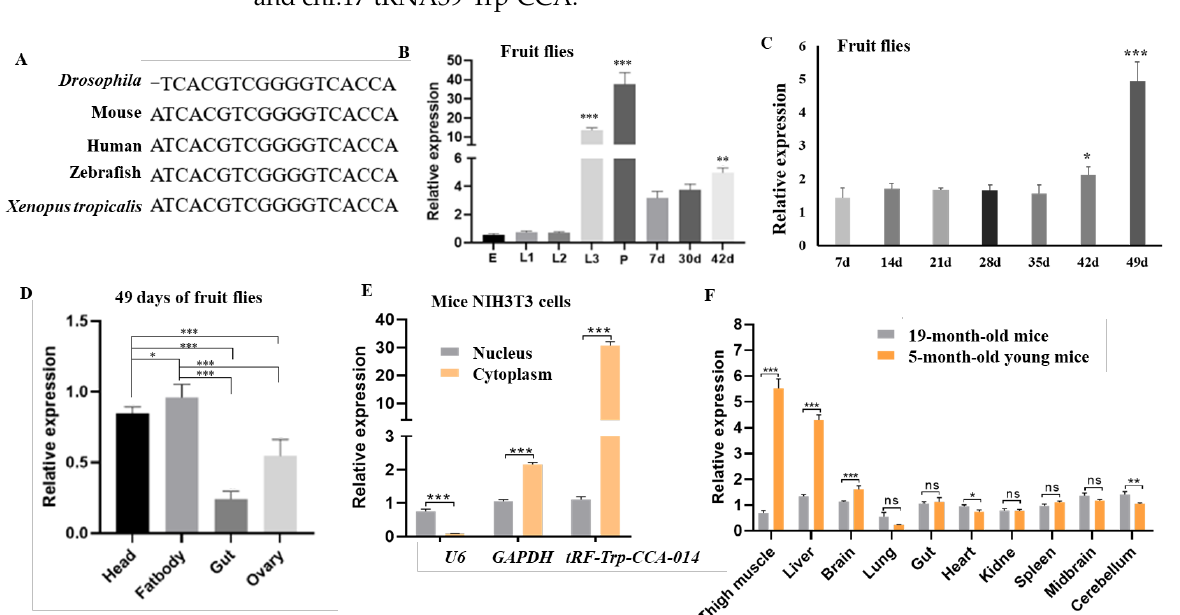
Figure 3. Expression features of tRF-Trp-CCA-014 in Drosophila and mice. ( A ) The sequence alignment of tRF-Trp-CCA-014 in Drosophila , mouse (a relational database of transfer RNA related fragments 3002a, tRFdb 3002a), human (from MINTbase v2.0), zebrafish (tRFdb 3038), and Xenopus trop-